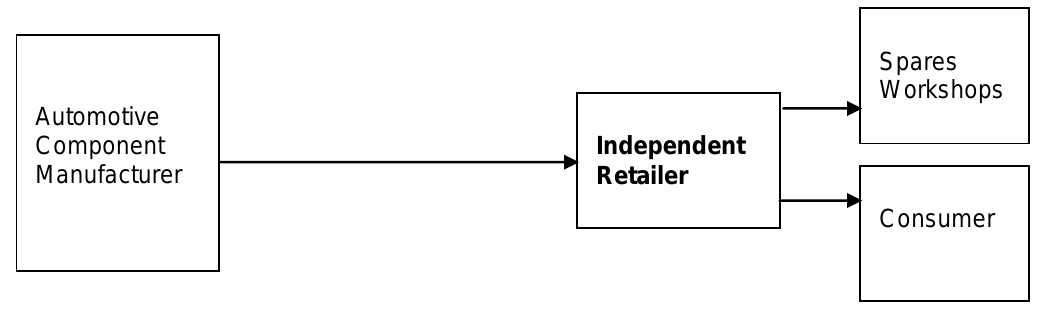
Figure 2(c): Component distribution channel – the Independent Retailer